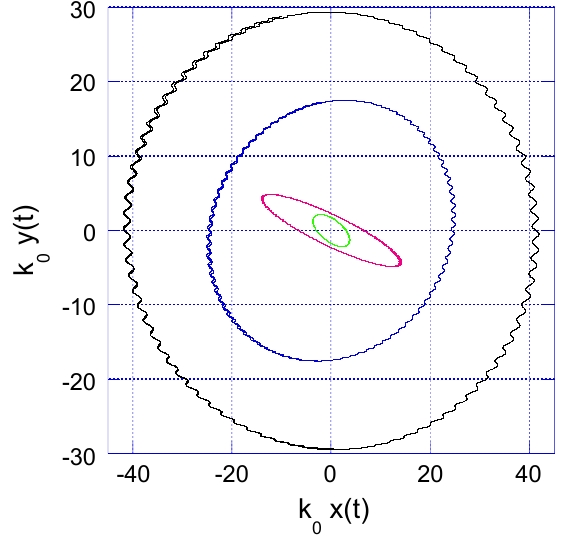
Figure 2. Parametric plots of normalized y ( t ) vs. x ( t ) for the cases of Figure 1. Color code is (a)-red, (b)-green, (c)-blue and (d)-black. k 0 × x ( t ) and k 0 × y ( t ) are dimensionless variables. The projection onto the xy -plane is (nearly) an ellipse, whose principal axes, overall amplitude and orientation depend on the initial conditions. All trajectories show besides a small oscillatory pattern due to the electron quiver motion.